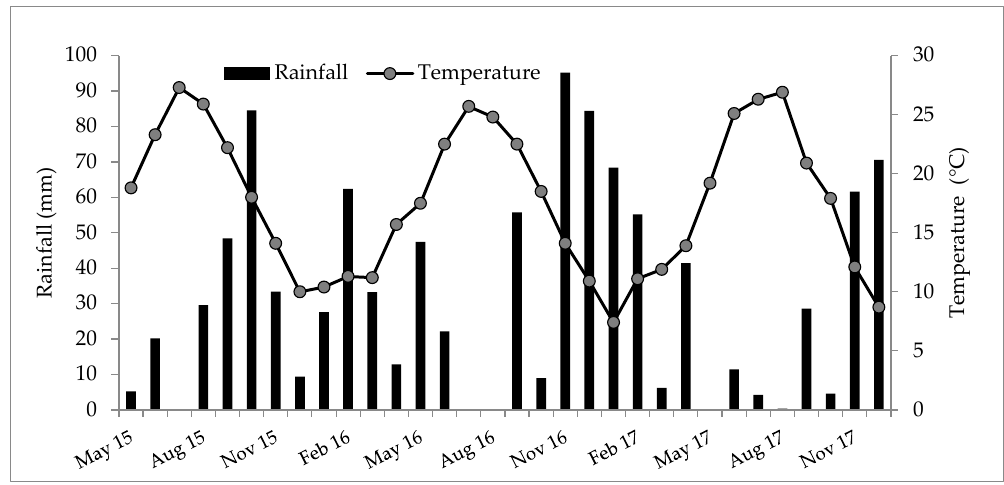
Figure 1. Monthly rainfall and mean temperature at the southern Sardinia site during the study period.